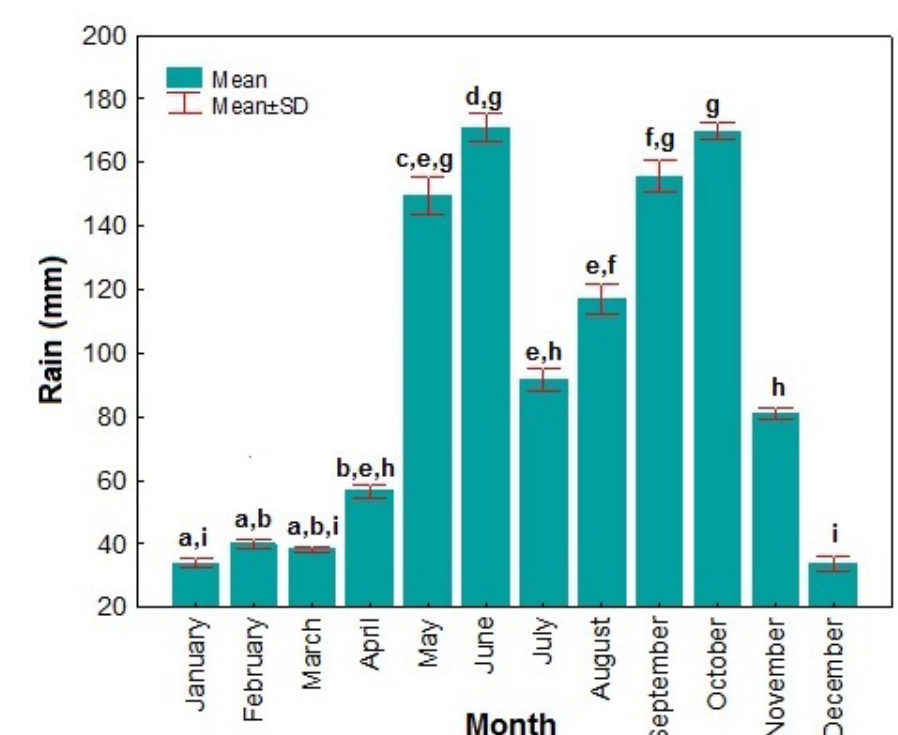
Figure 2. Historical mean monthly rainfall (in mm) in Cayo Coco through 1961–2020. Minor letters denoted significant differences among